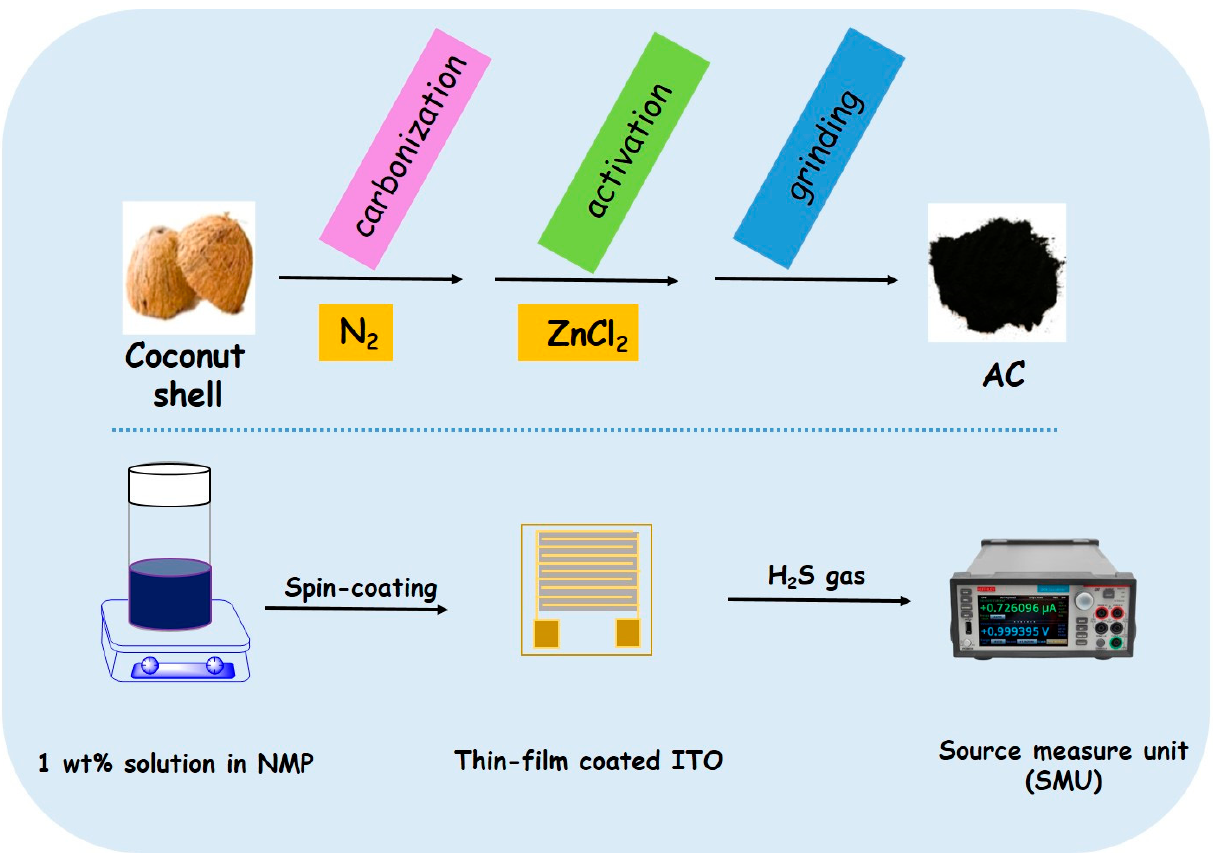
Figure 1. Schematic diagram of the formation of AC (top) and preparation of ITO sensor (bottom) for measuring gas-sensing properties of PUU-AC0, PUU-AC1 and PUU-AC3.